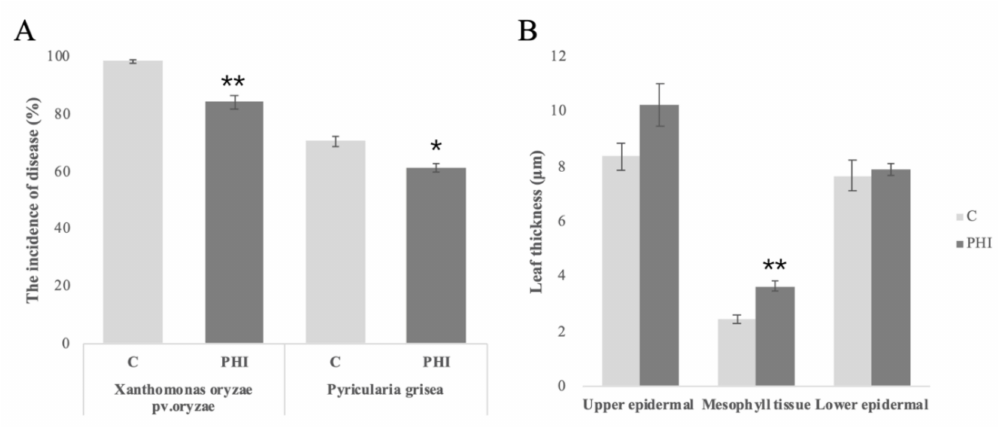
Figure 1. ( A ) The disease incidence rate of rice seedling between C (Control) and PHI (phosphite-treated) seedlings. ( B ) The thickness parameters of rice leaves between C (Control) and PHI (phosphite-treated) seedlings. Error bars represent the SE of three biological replicates. * p < 0.05; ** p <